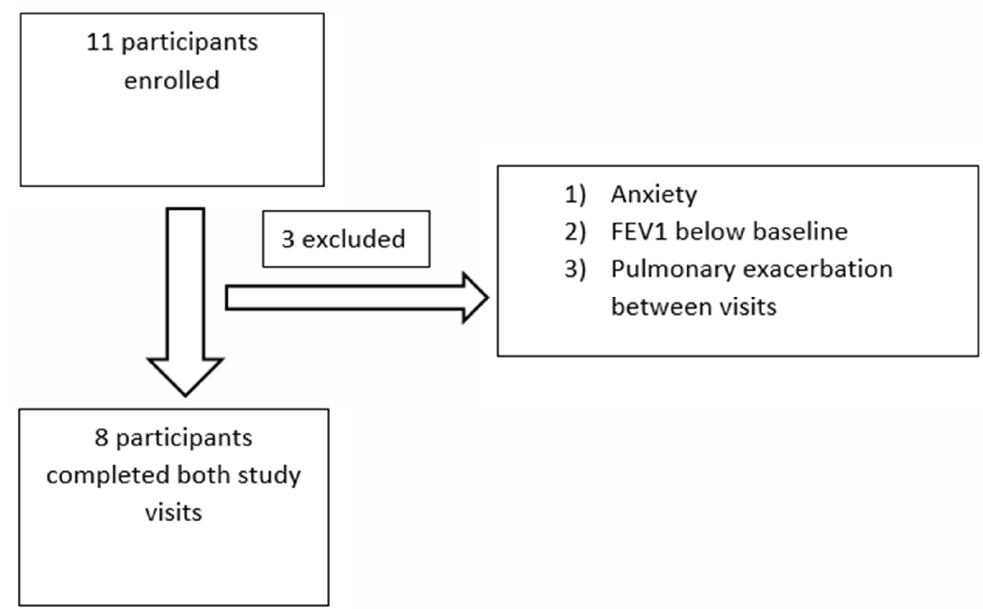
Figure 1. Flow diagram of participants enrolled in the observational trial. FEV 1 : forced expiratory volume in 1 second.